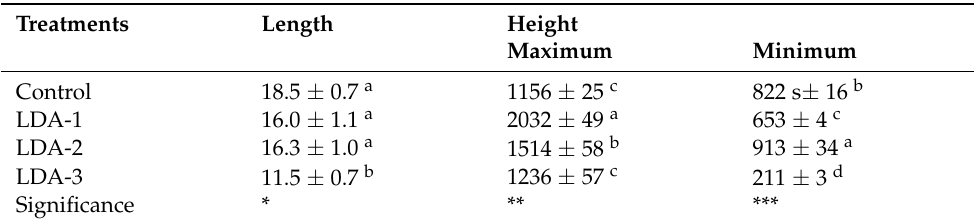
Table 3. Values of length and maximum and minimum heights of the fungal cell surface of F. solani ICADL1 observed by AFM.